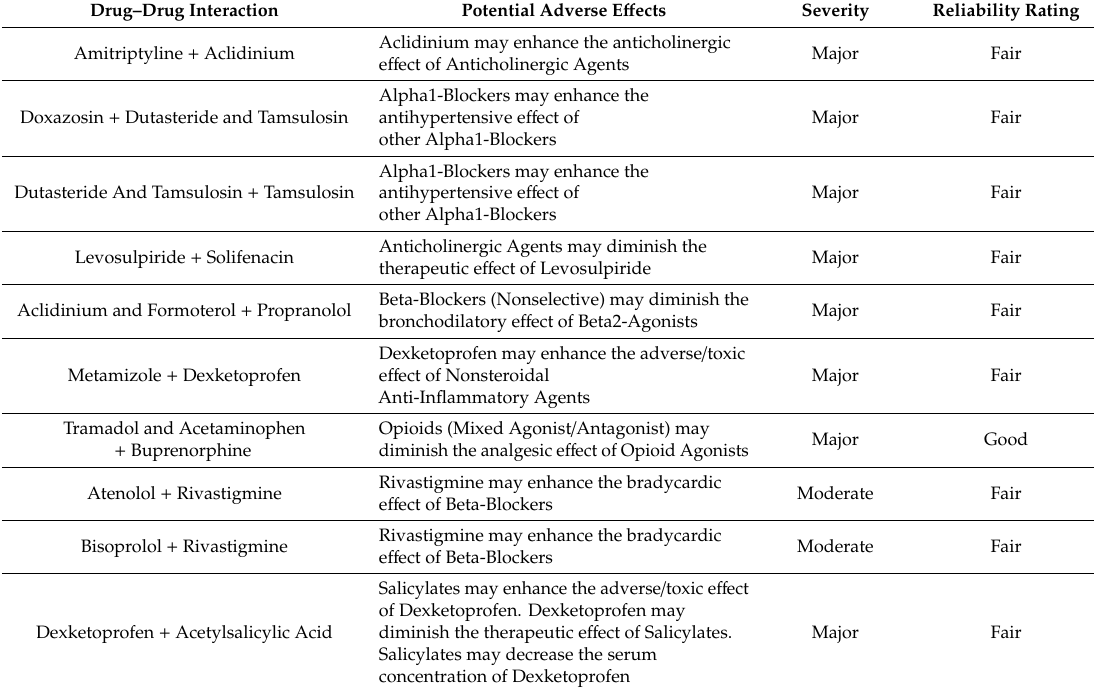
Table 5. Potential drug–drug interactions Type X (avoid drug combination) found in the studied CKD patients.